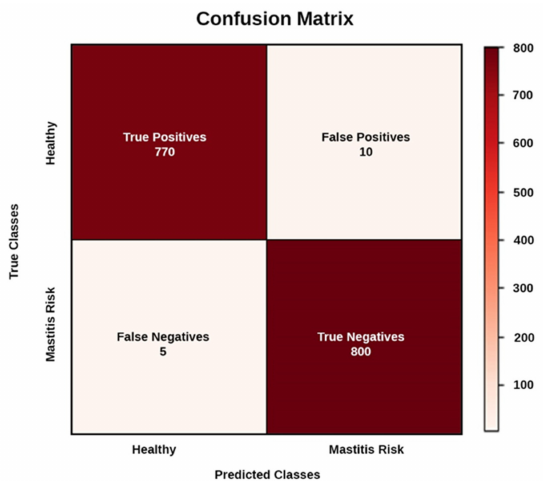
Figure 1. Confusion matrix of the top model (based on the random forest algorithm). The matrix is based on the performance of the model on the test set comprising 1585 samples (780 healthy and 805